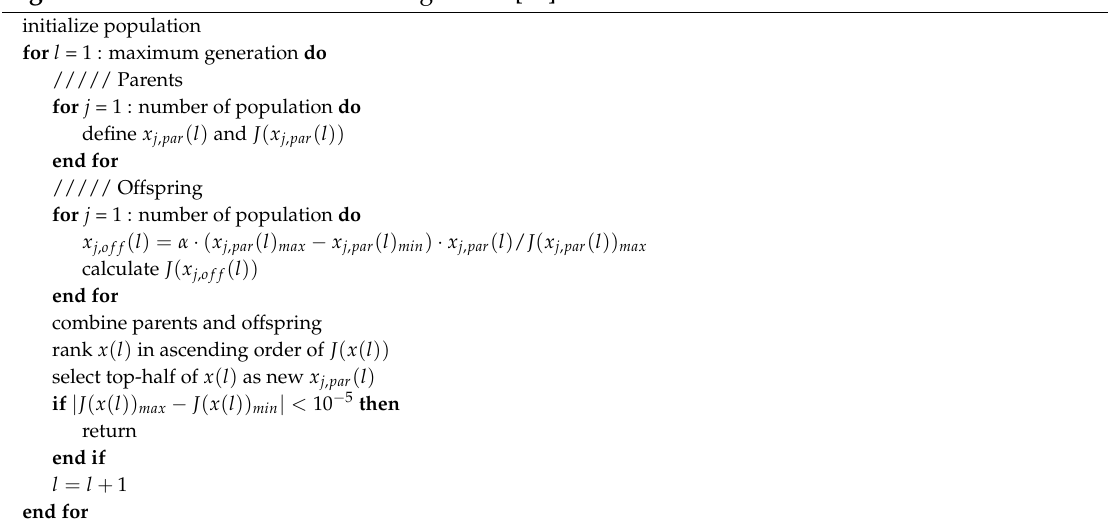
Algorithm 2 Pseudocode for the EP algorithm [18].